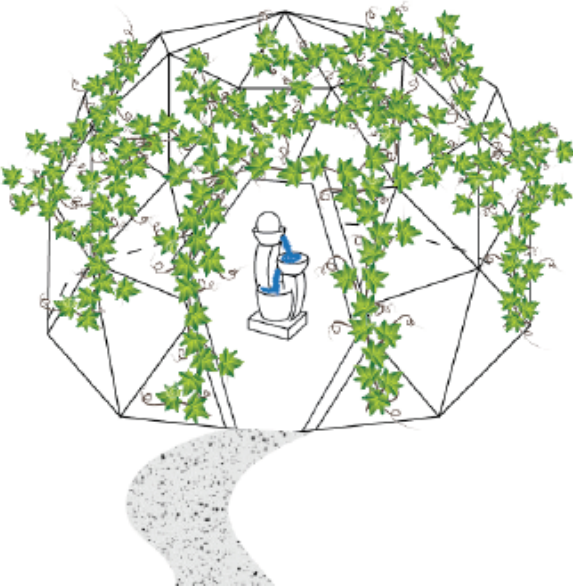
Figure 7. Sketch of the Boston intervention by team